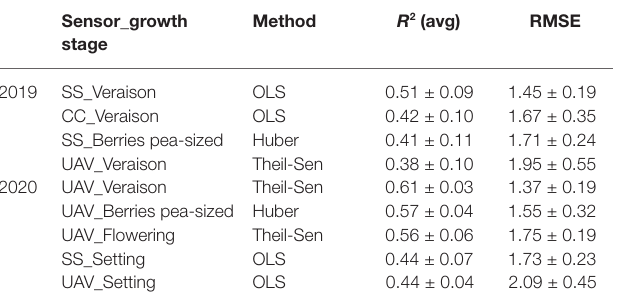
TABLE 4 | Selected best performed linear regression models performed using the highly correlated NDVI data from all four proximal and remote sensors to evaluate their performance in assessing the wine grapes quality characteristics (legend as for Table 3 ).